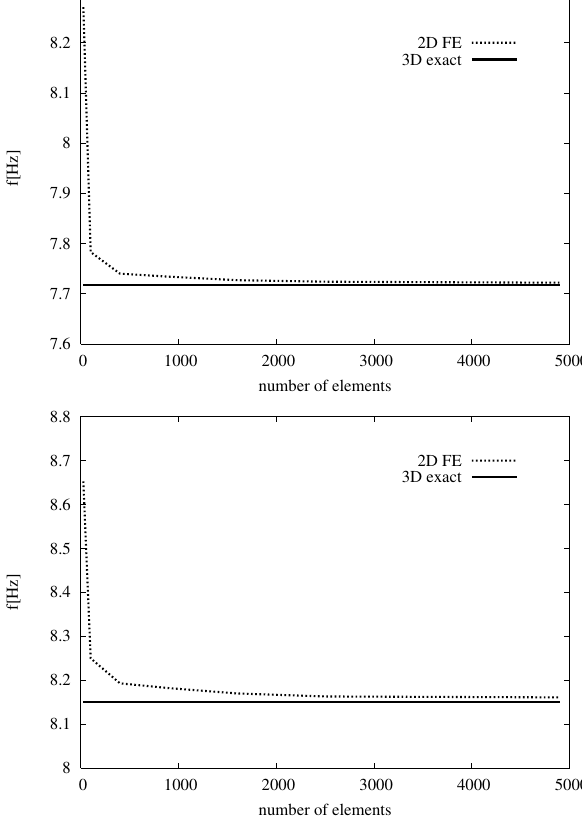
Figure 9: Third assessment for the 2D FE solution, simply supported composite cylinder 90 ∘ /0 ∘ /90 ∘ with thickness ratio R α /h=100. Frequency f[Hz] vs. number of elements for the mode (12,1) (at the top) and for the mode (10,1) (at the